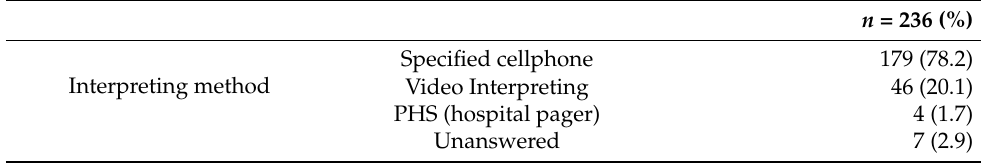
Table 1. Interpreting method used for remote medical interpreting.